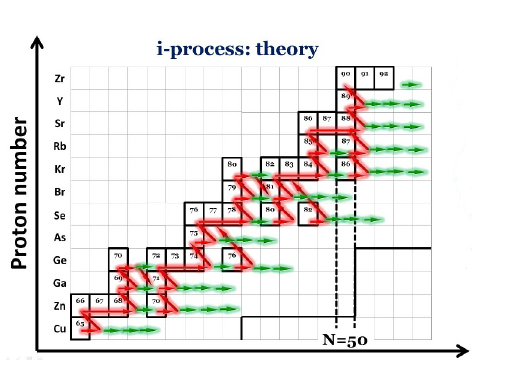
Figure 3. Typical pattern of the i-process. Green arrows mark the departure from the β stability valley. Red arrows indicate the main s-process